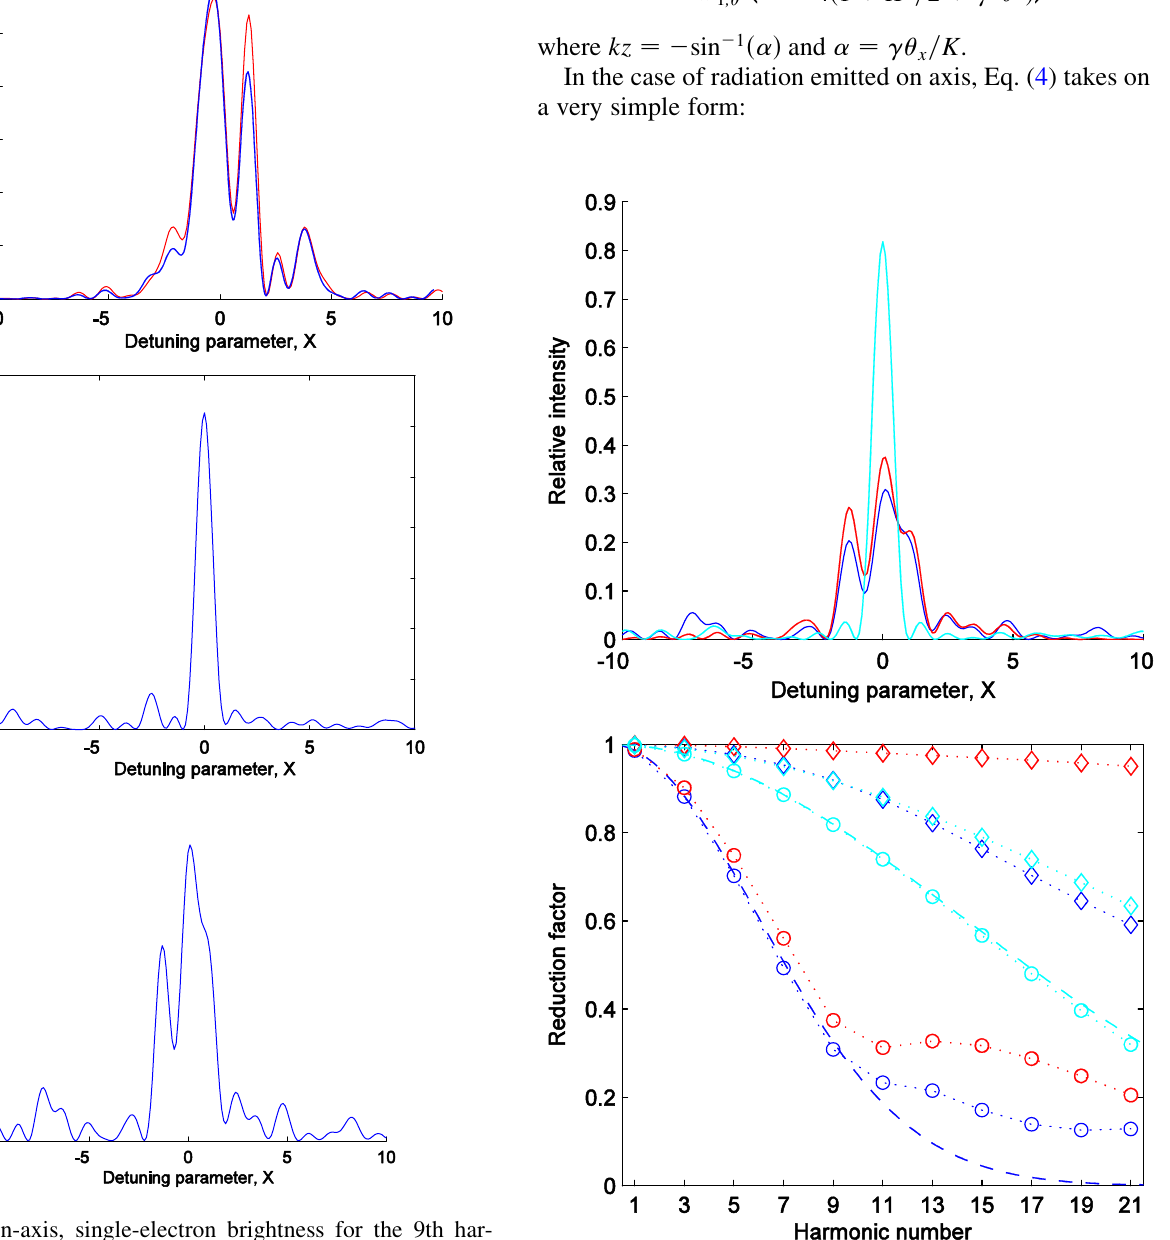
FIG. 11. On-axis single-electron brightness spectra for the 9th harmonic (upper) and reduction factors (lower) for peak (circles) and integrated (diamonds) brightness as a function of harmonic number for the phase errors of Fig. 2. Colors in both plots refer to those of Fig. 2. The dashed lines are Eq. (1) with (cid:1) (blue) and 2.8 (cid:2)